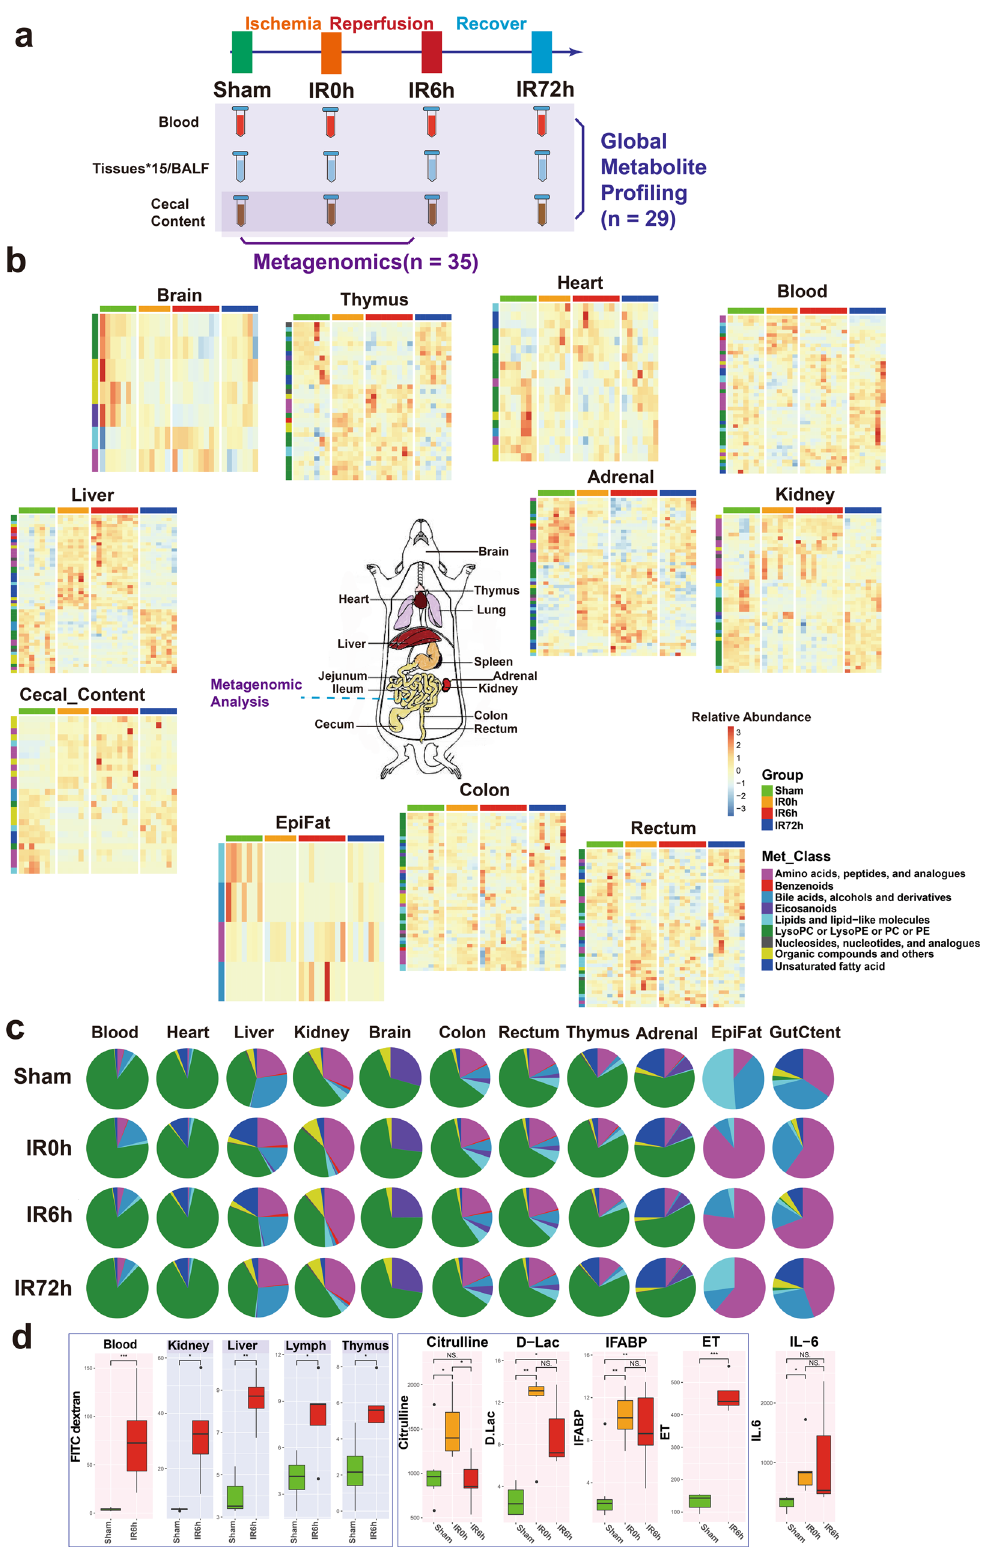
epididymal, showed a stress-non-recovery pattern (Supplemen- tary Fig. 7): their metabolic pro fi les differed signi fi cantly between Sham and IIR72h, indicating a long-lasting effect on these organs. Third, BALF and six organs, including jejunum, ileum, lung, lymph, spleen, and subcutaneous fat showed no noteworthy changes in metabolic pro fi les during IIR (Supplementary Fig.